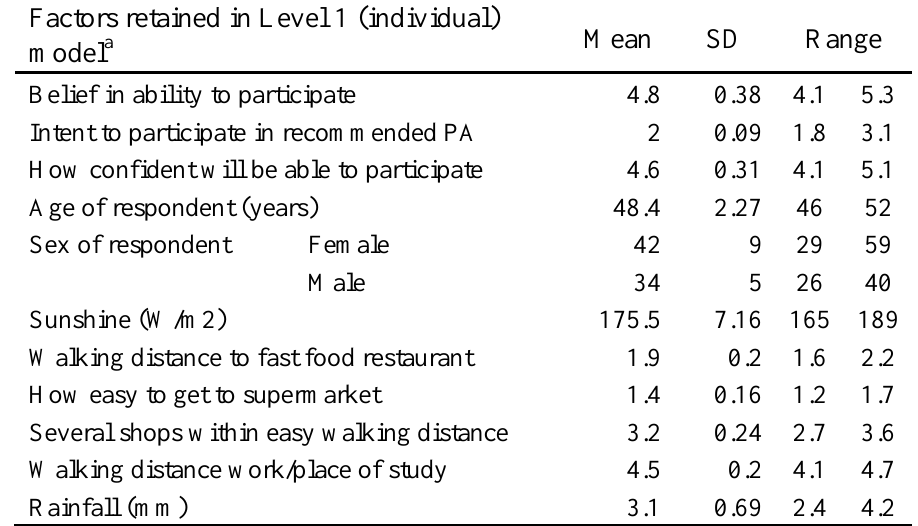
Table 4. Summary statistics for each factor retained in the level-1 (individual)